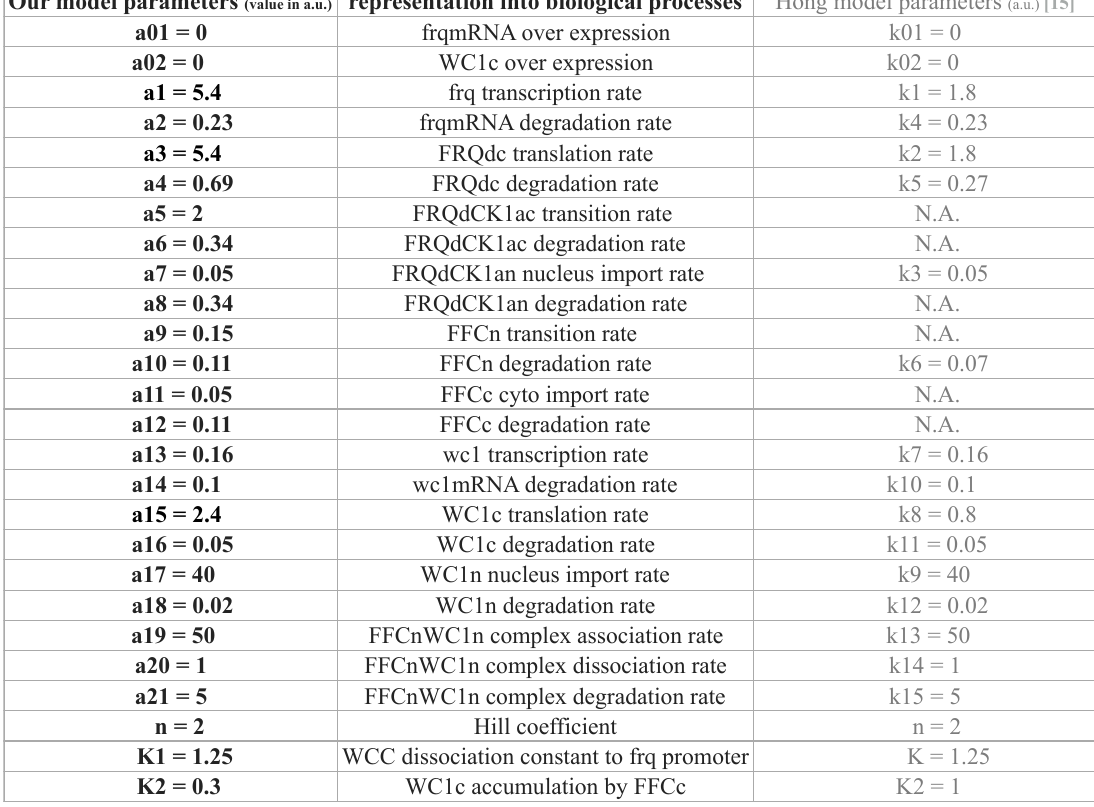
Figure A1. Kinetic parameters: A list of rate constants and their associated biological